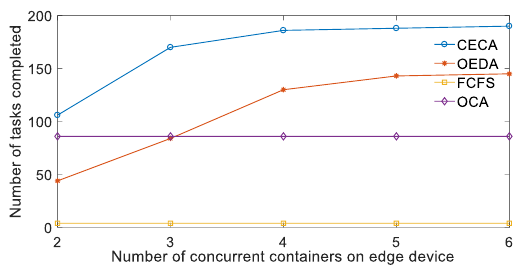
Figure 4. The impact of the number of concurrent containers of the edge device on task